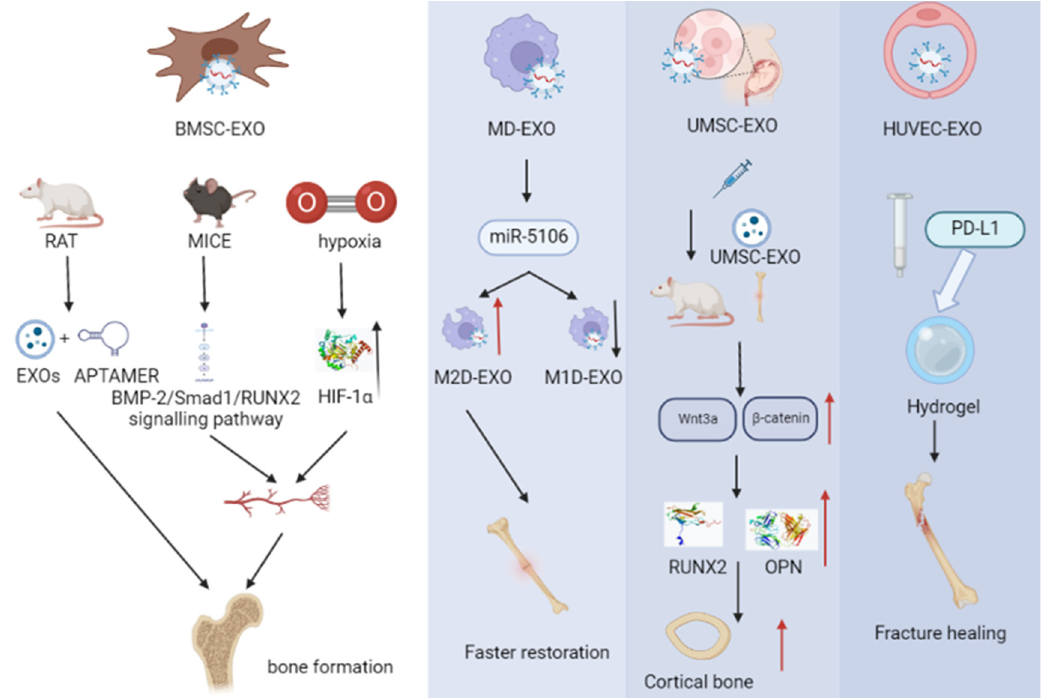
Figure 4. Exosomes act as drug delivery systems in fractures. Exosomes secreted from different stem cells can lead to osteogenic differentiation and promote bone healing.